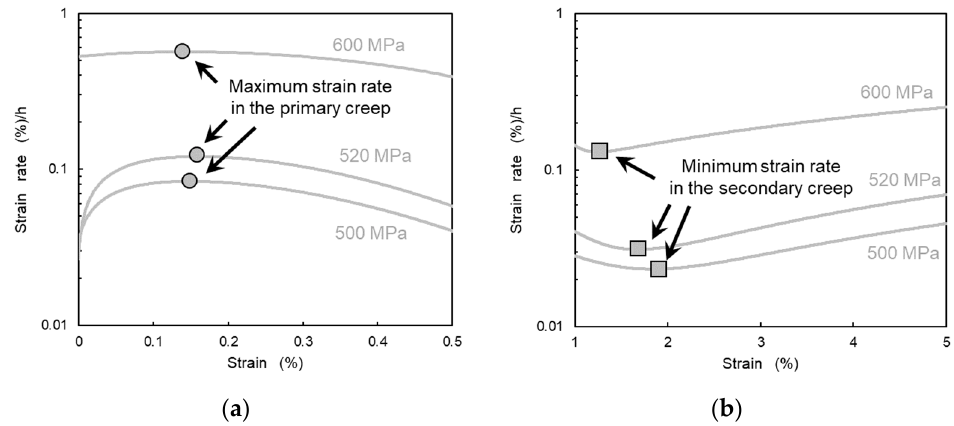
Figure 4. Creep curves at 760 °C. ( a ) Whole region of creep tests, ( b ) early stage of creep tests.